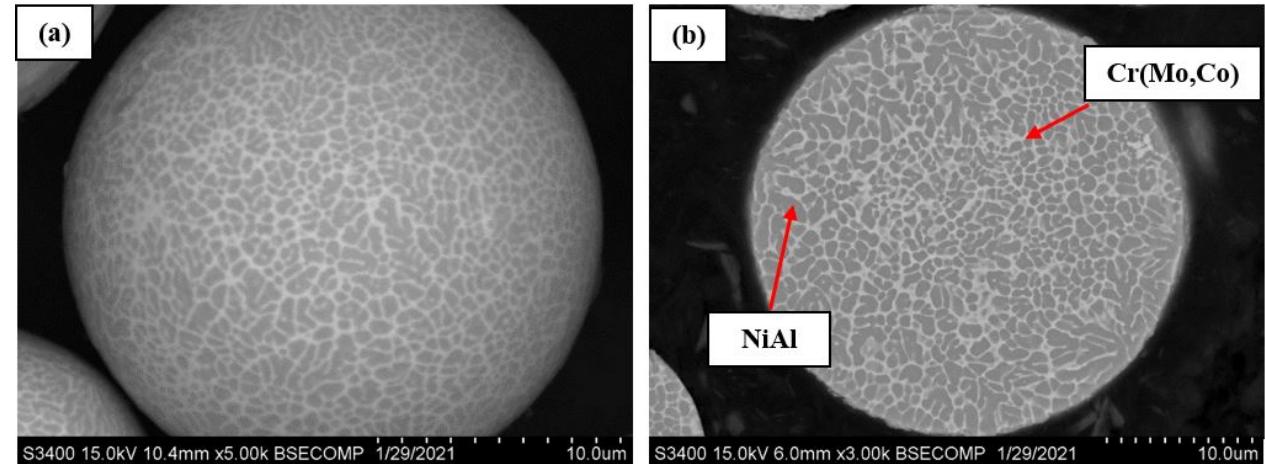
Figure 23. The microstructure of the surface ( a ) and the transverse cross-section ( b ) spherical powder of the NiAl–Cr– Co+15%Mo alloy.